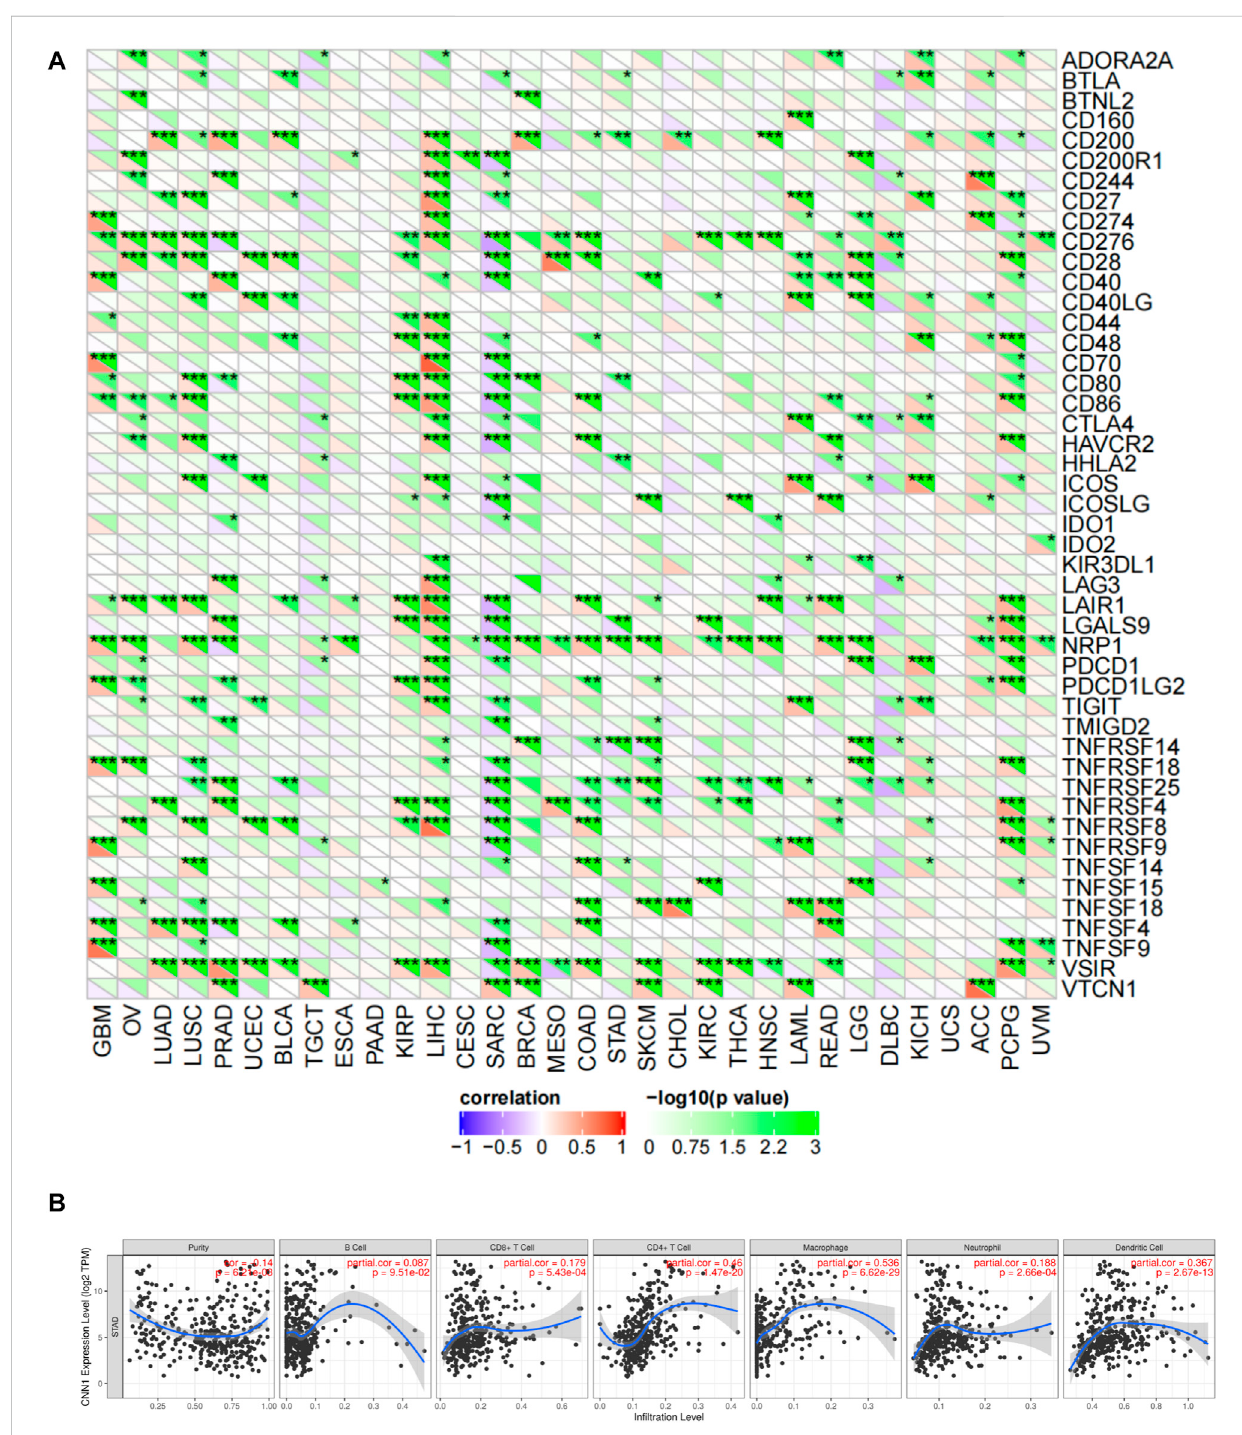
FIGURE 6 Correlation of CNN1 expression levels with immune checkpoint gene expression levels and immune cell in fi ltration. (A) Correlation of CNN1 expression with 47 immune checkpoint genes in pan-cancer using the Sangerbox online platform. (B) Correlation of CNN1 expression with immune cell in fi ltration in STAD using the TIMER